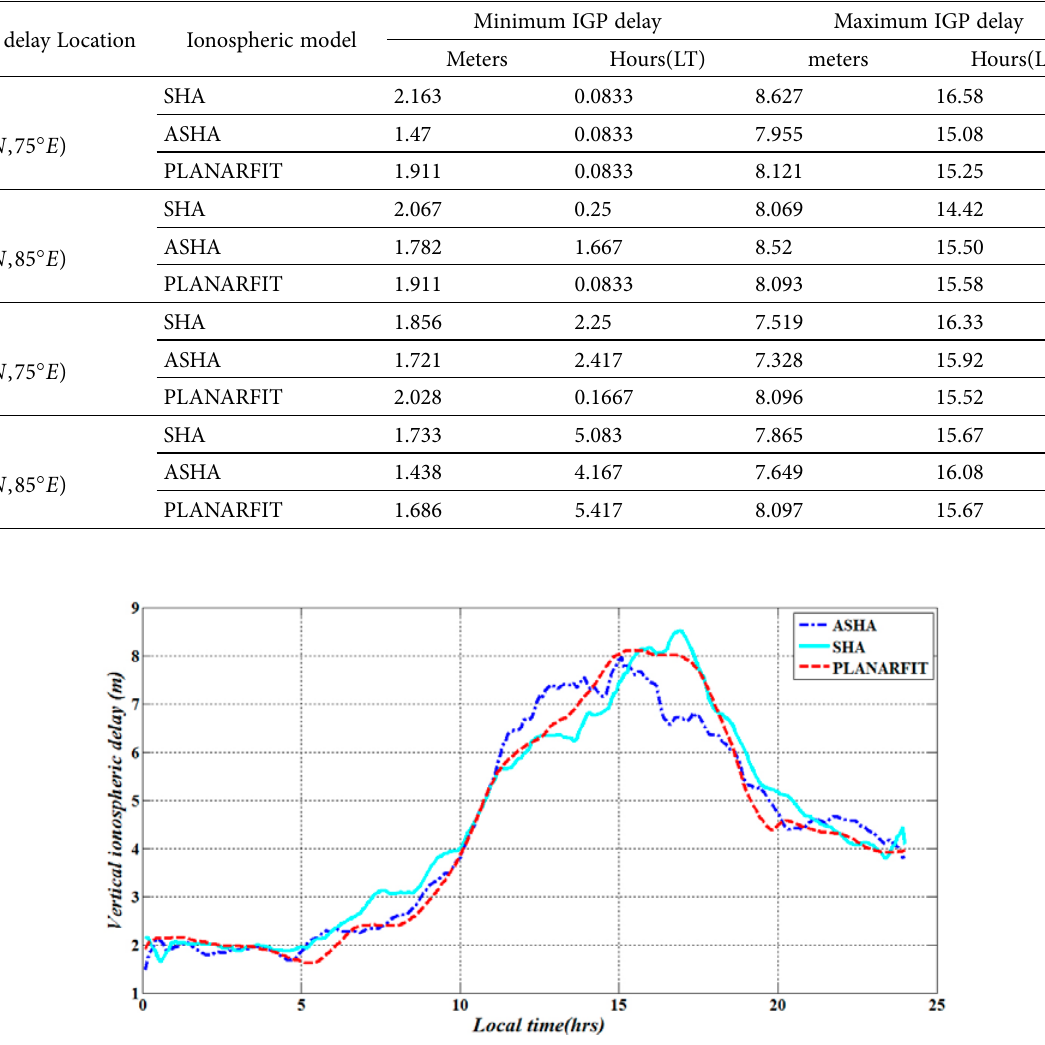
Fig. 2. Estimated vertical delay variations on a typical disturbed day (July 23, 2004) at IGP location (25° N , 75° E )